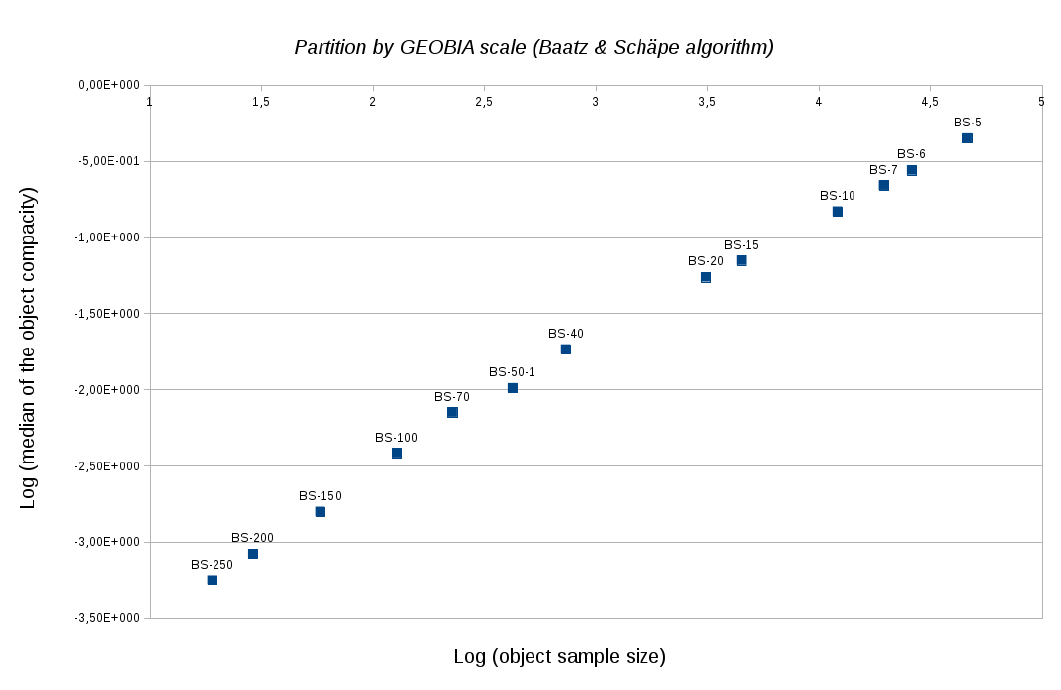
Figure 13. Median of the object compacity with the segmentation based on GEOBIA.